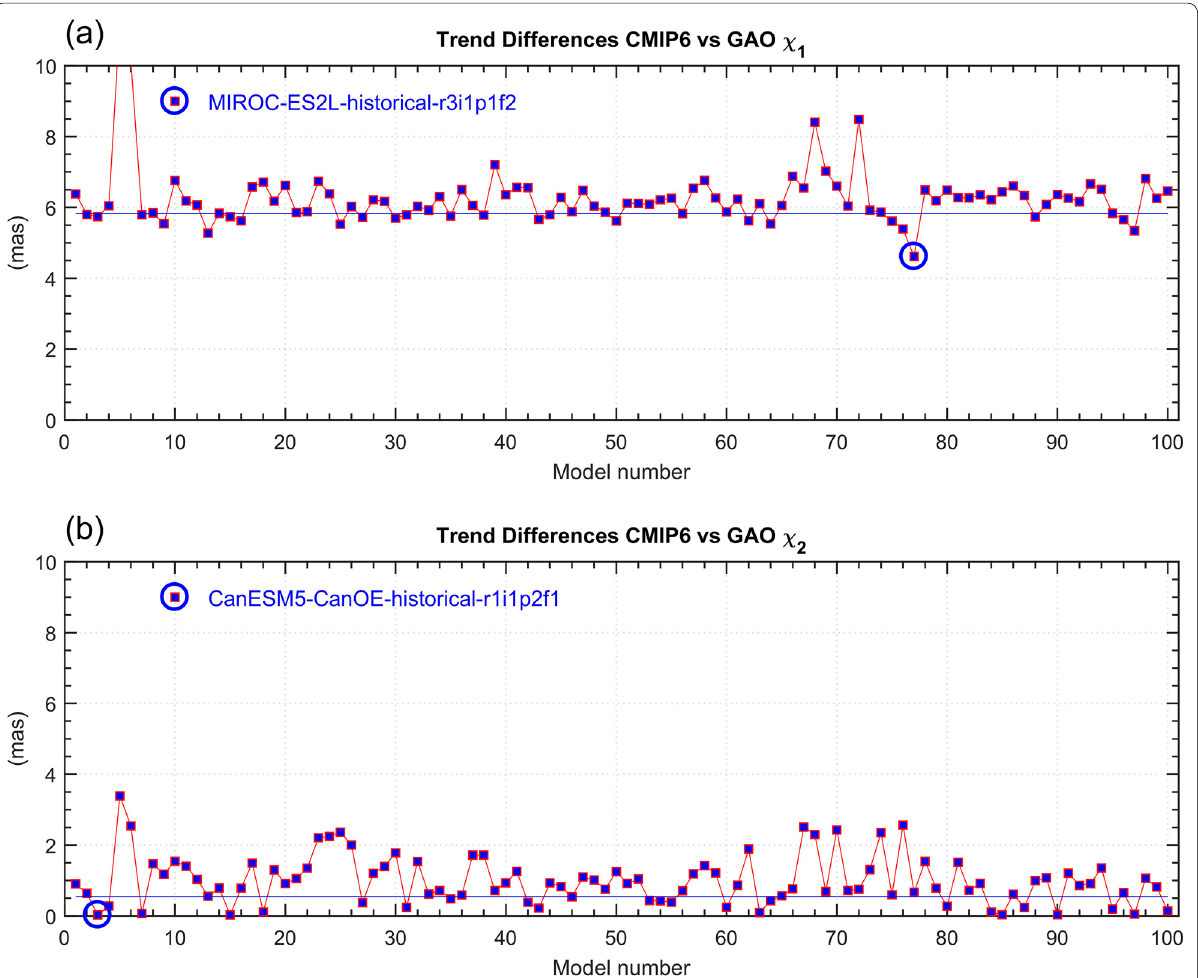
Fig. 2 Absolute values of the trend differences between GAO and HAM computed from CMIP6 in a χ 1 and b χ 2 components. Blue lines represent the first quantile. The model for which the trend differences are the smallest is indicated with a circle and